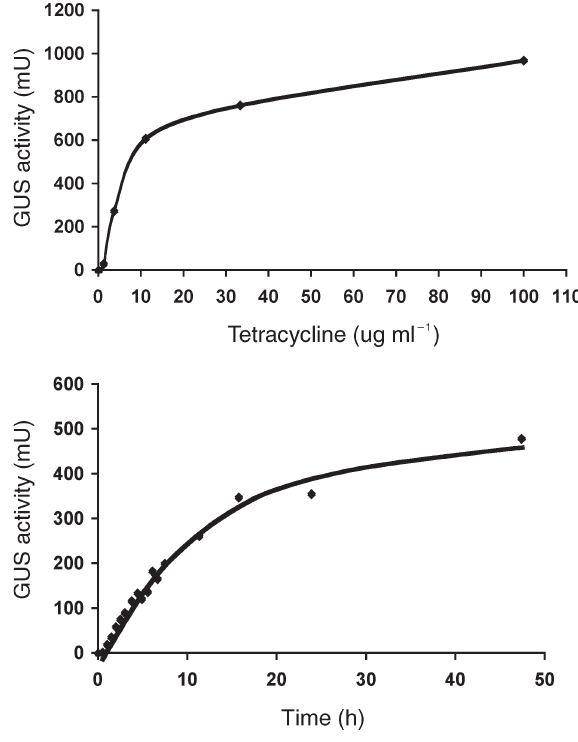
Figure 5. Dose–response and time course of tetracycline-dependent gene expression in Methanosarcina . Panel A, Plasmid pJK027A was integrated into the chromosome of strain WWM73 and the resulting strain was grown in the presence of various tetracycline concentra- tions to mid-exponential phase before assaying GUS activity as de- scribed. Panel B, The same strain was grown without tetracycline until the culture reached early exponential phase. Tetracycline was then added at a concentration of 100 µg ml –1 . At various times, sam- ples were withdrawn and assayed for GUS activity.